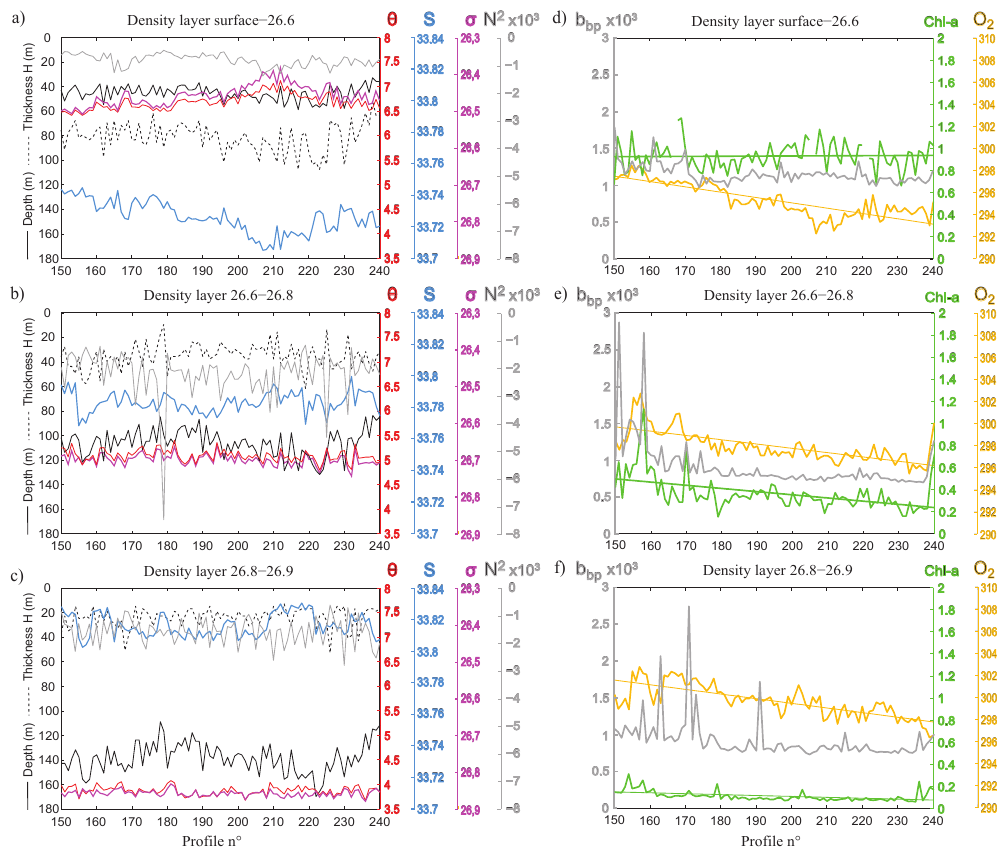
Figure 13. Temporal evolution of physical and biological properties during the eddy entrapment of bio-profiler #4 for three density layers, with sigma ranges of surface to 26.6, 26.6–26.8, and 26.8–26.9. Left column plots (a–c) show physical properties: mean depth (in m, black line and scale), thickness (in m, dashed black line and black scale), temperature ( θ , in ◦ C; red line and scale), salinity ( S , unitless; blue line and scale), density ( σ , in kgm − 3 ; purple line and scale), and Brunt–Väisälä frequency squared ( N 2 , in s − 2 ; grey line and scale). Right column plots (d–f) show biogeochemical properties: mean chlorophyll (Chl a , in µgL − 1 ; green line and scale), particulate backscattering ( b bp , in m − 1 ; grey line and scale), and oxygen concentrations (O 2 , in µmolkg − 1 ; orange line and